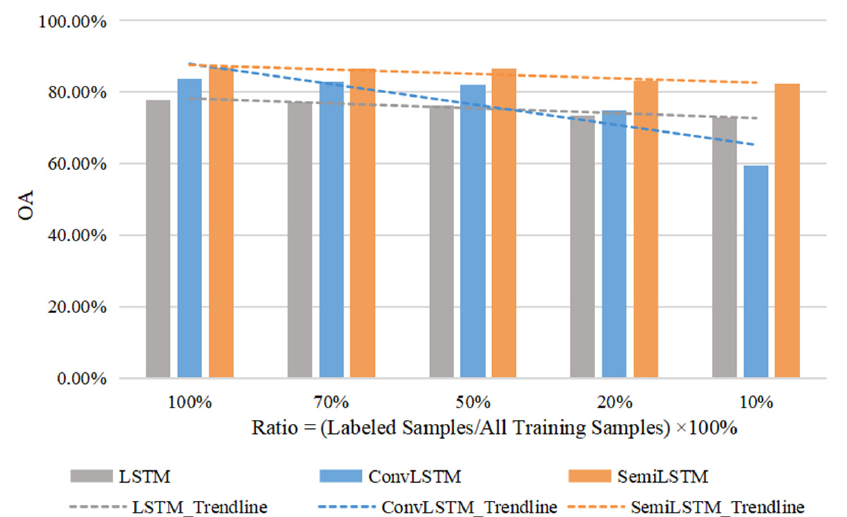
Figure 9. The results of comparative experiments where the ratios of known labels are 100%, 70%, 50%, 20%, and 10% respectively. The dotted lines are a linear fit to OA values. In short, reducing the model’s dependence on training samples is beneficial to image classification tasks. It not only reduces the difficulty of collecting time series labeled data (especially in complex environments and terrain conditions), but also reduces the cost and workload of labeling